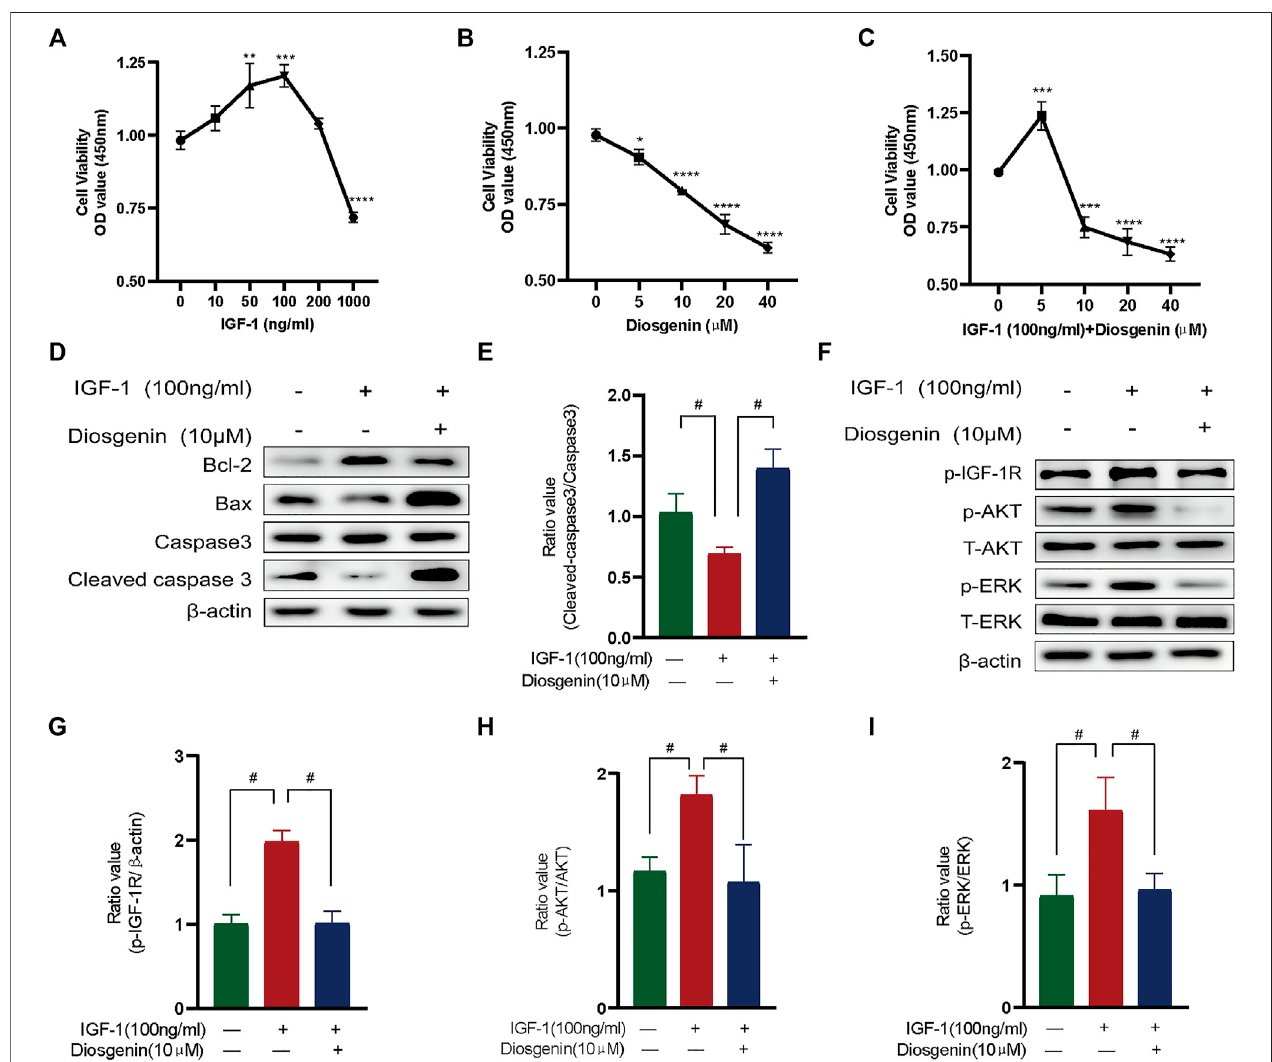
FIGURE8| Diosgenininducesapoptosisin Nthy - ori3 - 1 cellsbyinhibitingthephosphorylationofIGF-1R invitro phosphorylationofIGF-1R invitro . (A) Cellviabilitywith IGF-1(ng/ml)atincreasingconcentrationsafterculturingfor48 h. (B) Cellviabilityafter24 hofculturewithdiosgenin( μ M)atdifferentconcentrations. (C) CellviabilitywithIGF1 (100 ng/ml) and diosgenin ( μ M) at different concentrations. (D) Apoptosis-related proteins were detected using WB as described above. ß -actin was used as an internal reference. (F) DiosgenindevitalizedthePI3K/AKTandRaf1/MEKsignalingpathwaysbyinhibitingp-IGF-1R. (E,G – I) Dataareshownasthemean ± standarddeviation of three independent experiments. * p < 0.05, ** p < 0.01, *** p < 0.001 and **** p < 0.0001 compared with the 0 group. # p < 0.05 compared with the IGF-1 group.